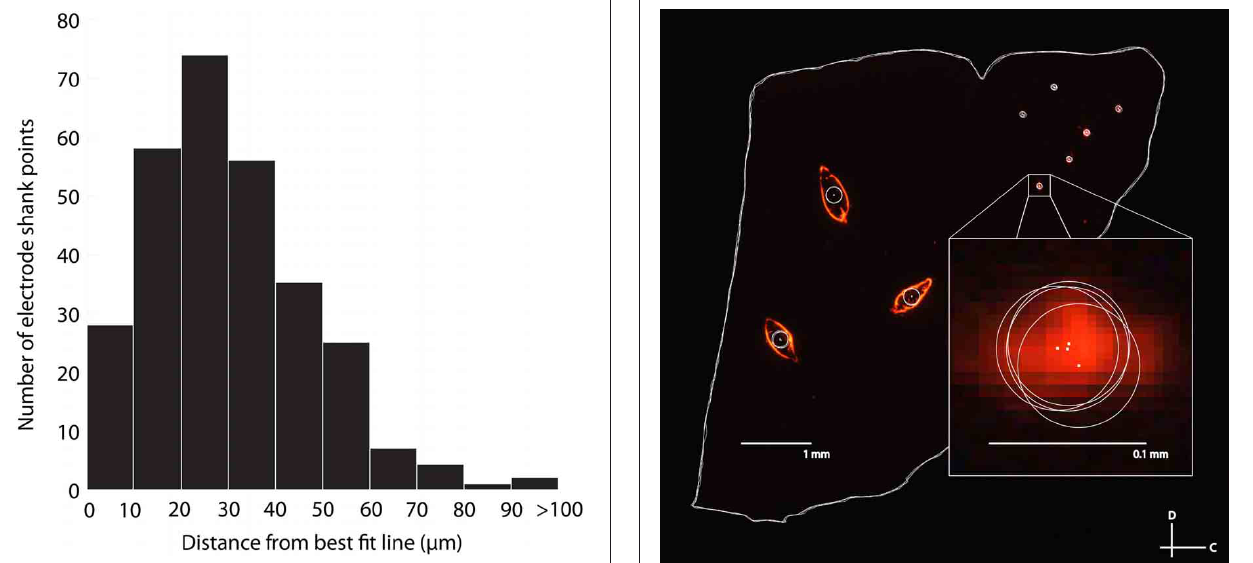
FIGURE 10 | A fluorescent image of a sagittal slice traced by four separate individuals for the second error analysis. The large white circles correspond to the three reference points and the small white circles correspond to the different electrode track placements (three bi-shank placements). Tracing error between individuals was determined by measuring the distance between the estimated electrode track point or reference point (i.e., the center of the circles indicated by white dots) between each pair of individuals, and averaging across all pairs of individuals and placements for five different slices. C, caudal; D,